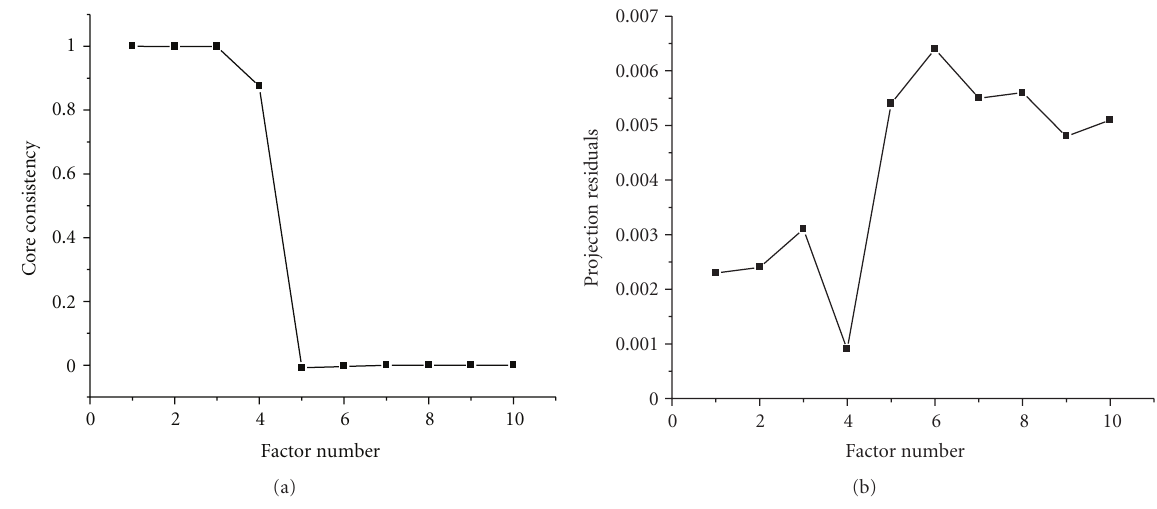
Figure 2: The results of factor-determining of the HPLC-DAD data arrays by CORCONDIA (a) and LTMC (b).